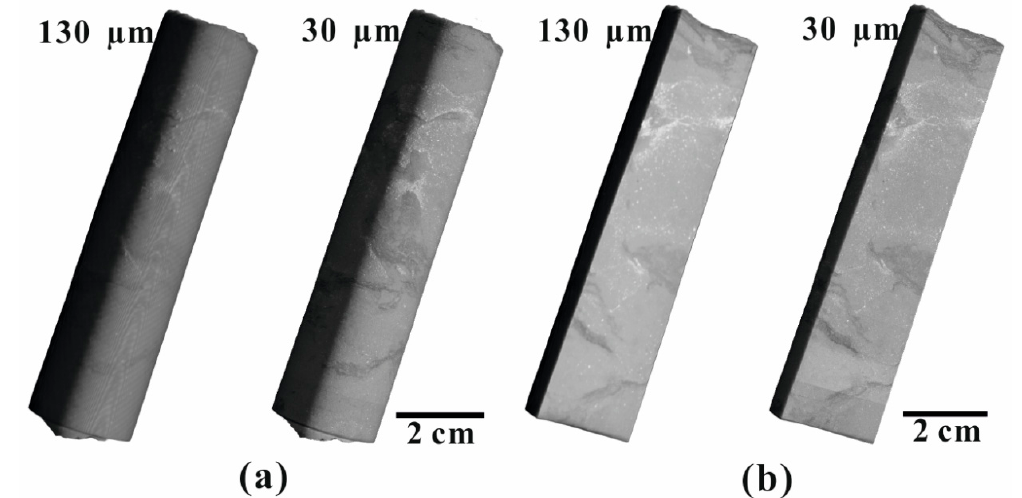
Figure 4. Rendered X-ray micro-CT images of cylindrical sample A ( a ) and its vertical section ( b ) at the resolutions of 130 and 30 µm.